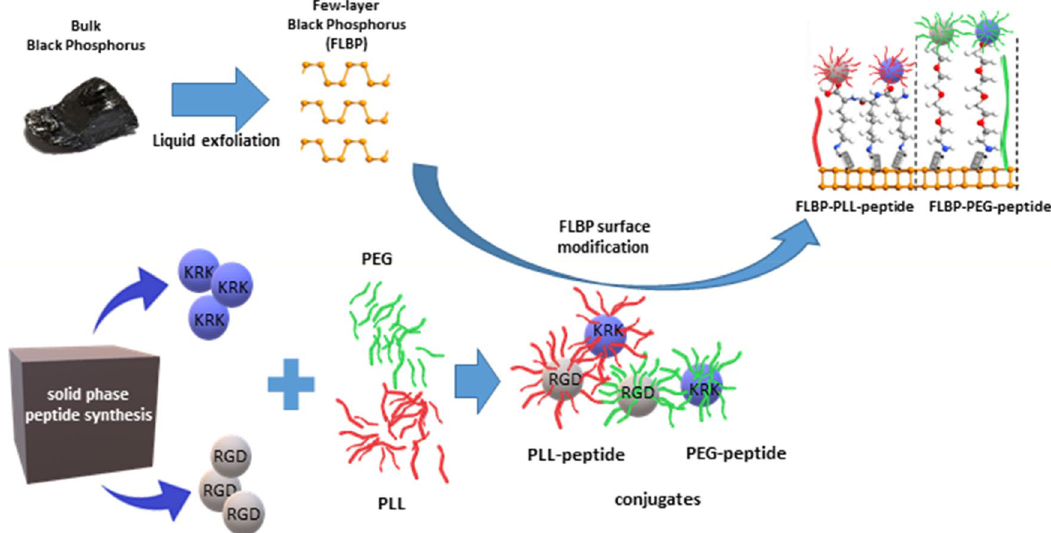
Figure 1. Scheme processes to yield FLBP-linker-peptide conjugates [partially drawn with QuantumATK Q-2019.12 (https:// www. synop sys. com/ silic on/ quant umatk/ resou rces/ relea se- notes.